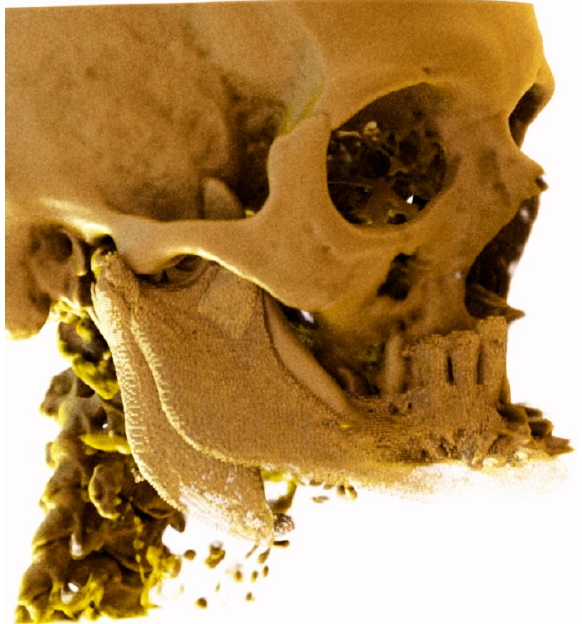
Figure 2. After the resective surgery of this lesion, the patient presented tumor recurrence within a few months. For this reason, she underwent two additional resective surgeries to remove the tumor. In the end, the patient underwent the complete removal of the body of the jaw.